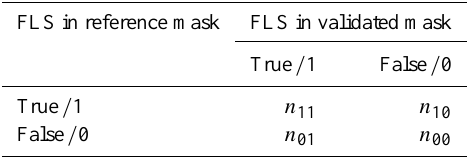
Table 1. Layout of the confusion matrices used to calculate the dif- ferent statistical measures. n is the number of